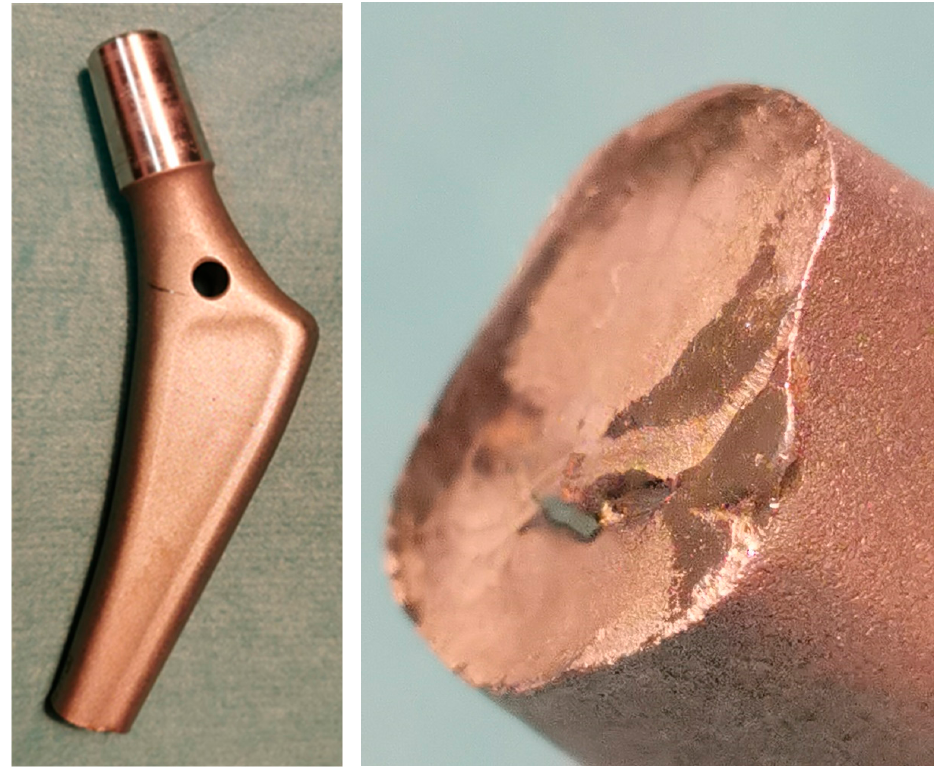
Figure 6. Break of the stem of the hip prosthesis and macro-photograph of the surface of its breakthrough.